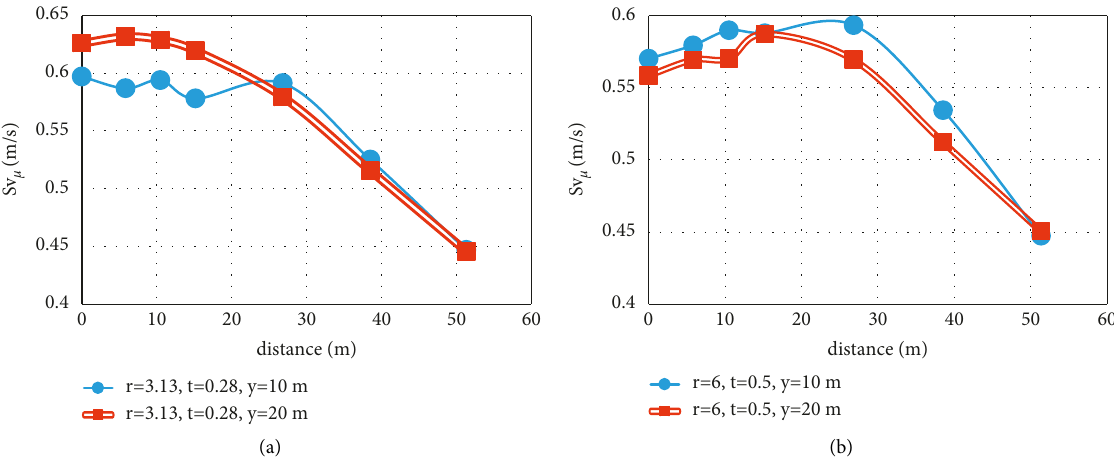
r=3.13, t=0.28, y=10 m r=3.13, t=0.28, y=20 Figure 7: The effect of change in overburden depth on ground surface velocity for models (a) 2 and 36 and (b) 3 and 35 of Table